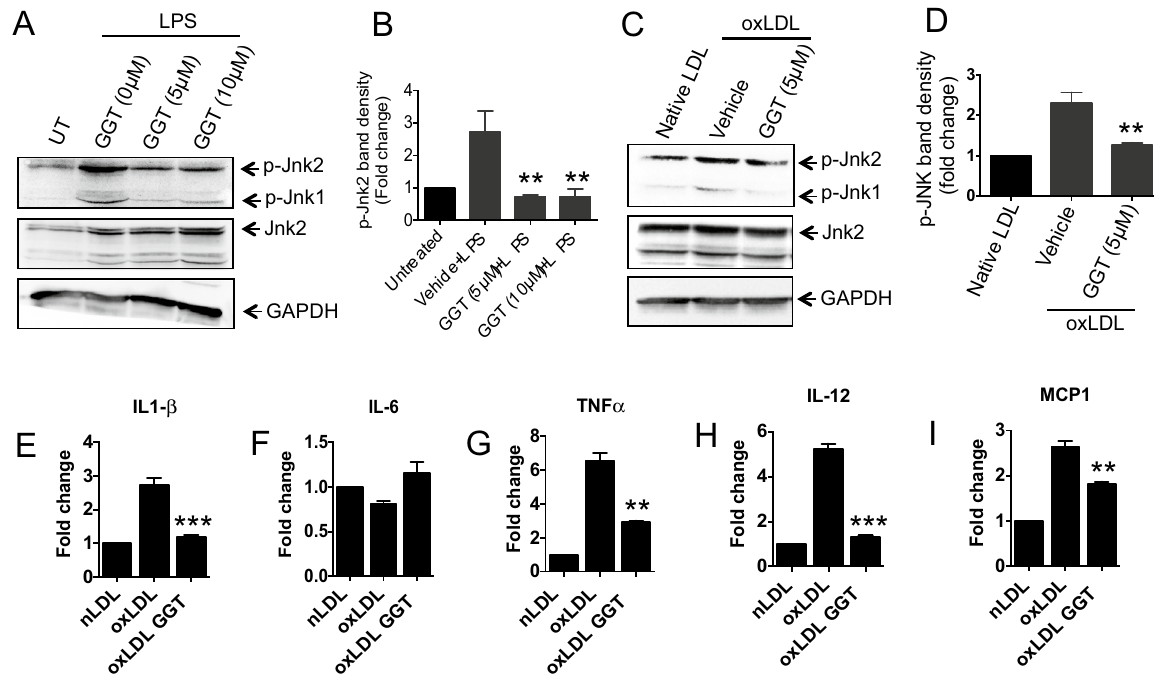
Figure 7. Ginkgetin blocks proatherogenic JNK2 activation and oxLDL-induced upregulation of proinflammatory gene expression in macrophages. Macrophages were treated with two doses of ginkgetin (5 or 10 µM) for 3 h followed by stimulation with E. coli LPS for 30 min. Immunoblot analysis was performed on whole cell lysates to evaluate phosphorylated JNK (p-JNK). ( A ) Representative immunoblot images showing levels of p-JNK1/2, total JNK, and GAPDH proteins (loading control). ( B ) Quantitative analysis of p-JNK2 levels after normalizing with total JNK-2 protein expression. Student’s t -test; ** P < 0.01, mean ± SEM. ( C ) Representative immunoblot images showing levels of p-JNK1/2, total JNK, and GAPDH proteins in macrophages stimulated by oxLDL or native LDL. ( D ) Quantitative analysis of results from C. Student’s t -test; ** P < 0.01, mean ± SEM. Two independent biological replicates and three experimental repeats for each set of data were performed. For qRT-PCR analysis, macrophages were treated with 10 µM ginkgetin for 3 h followed by oxLDL (50 µg/mL) overnight treatment at 37 °C. mRNA was harvested from the cells, and qRT-PCR was carried out using SYBR green gene expression assay to evaluate Il1β ( E ), Il6 ( F ), Tnfα ( G ), Il12 ( H ) and Mcp-1 ( I ). n = 2 biological repeats and 3 experimental repeats. One-way ANOVA followed by Bonferroni’s multiple comparison test; ** p < 0.01, *** p <